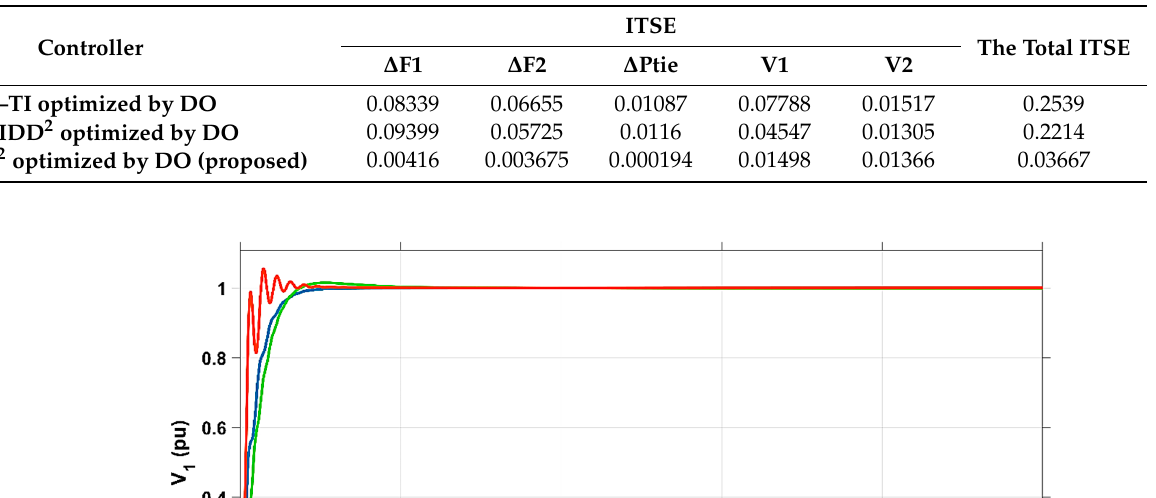
Table 7. Dynamic specifications of the investigated system represented as ITSE value using different controllers under scenario 5 impact.